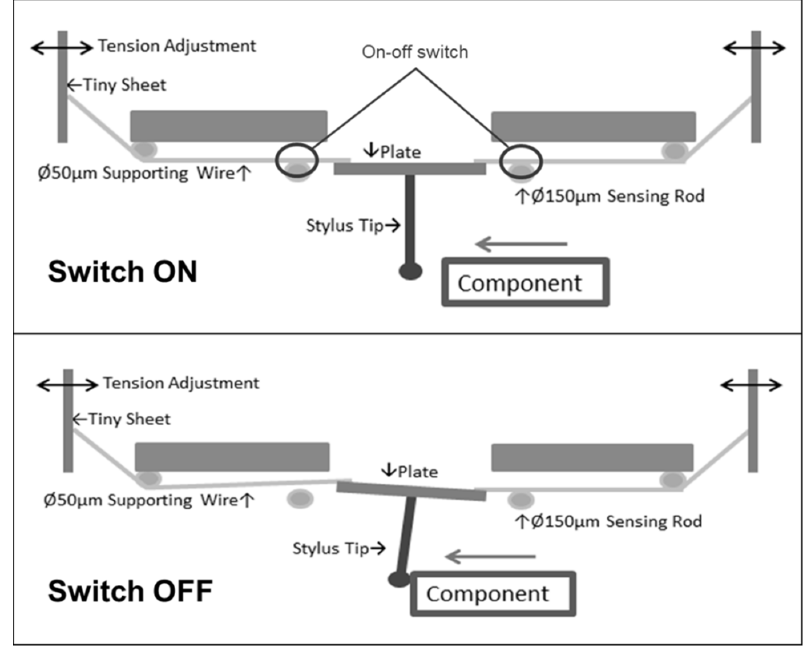
Figure 1. Tactile triggering mechanism of the proposed tri ‐ switches probing head.